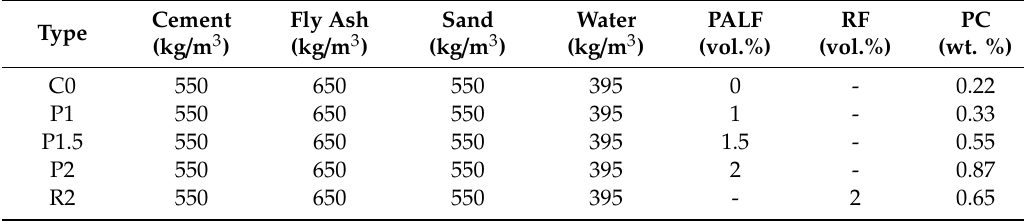
Table 1. Compositions of all five types of mortar used in this project.